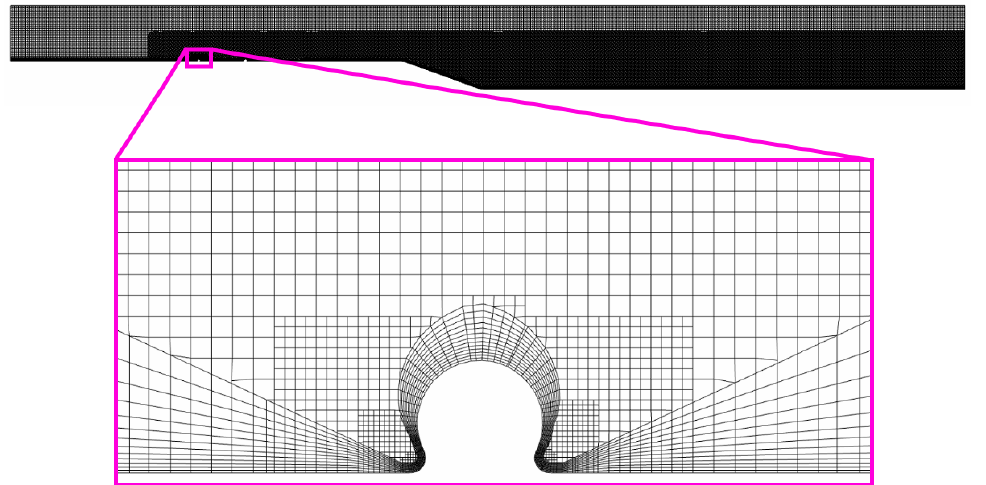
Figure 5. Computational grid surrounding the knitted wire mesh on plane